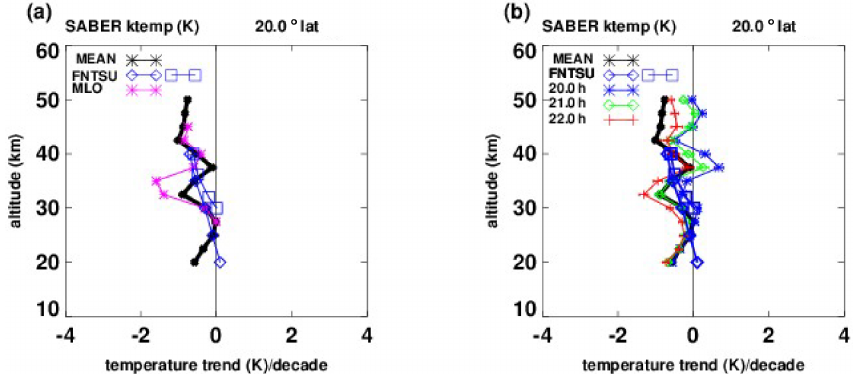
Figure 4. Temperature trends (K per decade) vs. altitude. (a) Black asterisks: trends based on SABER zonal means (over longitude and local time) at 20 ◦ N; blue diamonds: Funatsu et al. (2016) Aqua; data at 13:30 and 01:30, low latitudes (0 to 30 ◦ N); blue squares: Funatsu Aqua at 20 ◦ N; magenta asterisks: lidar measurements at Mauna Loa Observatory (MLO, 19.51 ◦ N), (b) Black asterisks: same as (a) , blue, green, red: estimates at 20:00, 21:00, 22:00LT, based on SABER data.